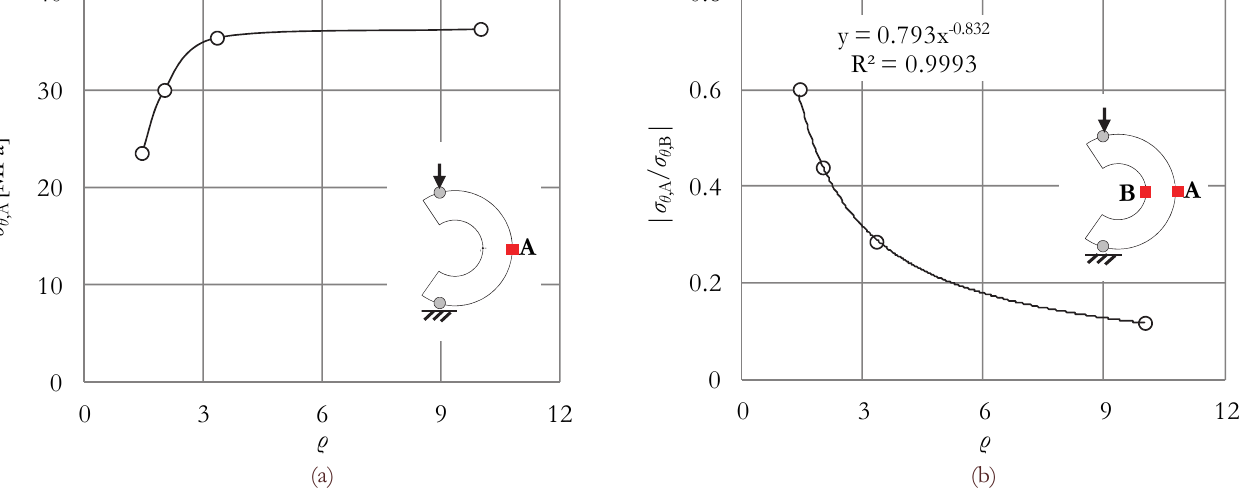
Figure 12: The dependence of the (a) maximum tensile stress and (b) the ratio of the maximum tensile stress over the respective com- pressive one, on the values of the radii ratio ρ